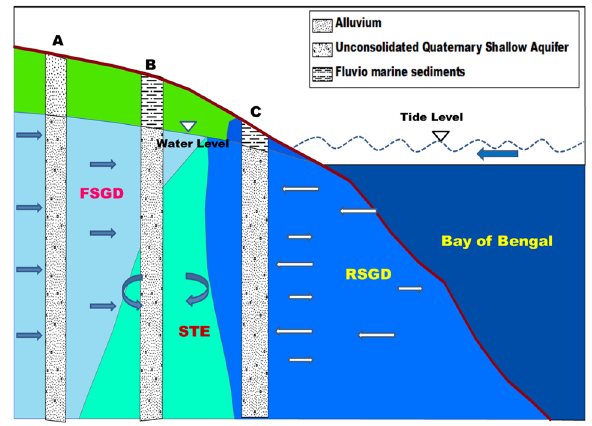
Fig. 8 Schematic diagram of process associated with SGD in Cole- roon river estuary ( A, B, C litho logs, FSGD fresh groundwater dis- charge, STE subterranean estuary, RSGD recirculated submarine